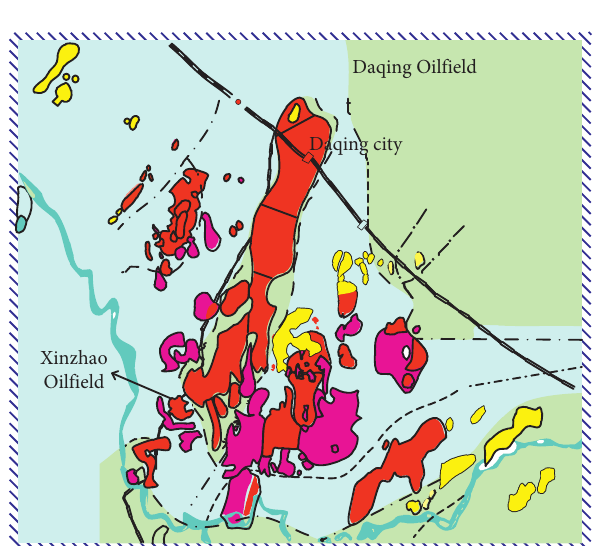
Figure 4: Daqing Oilfield